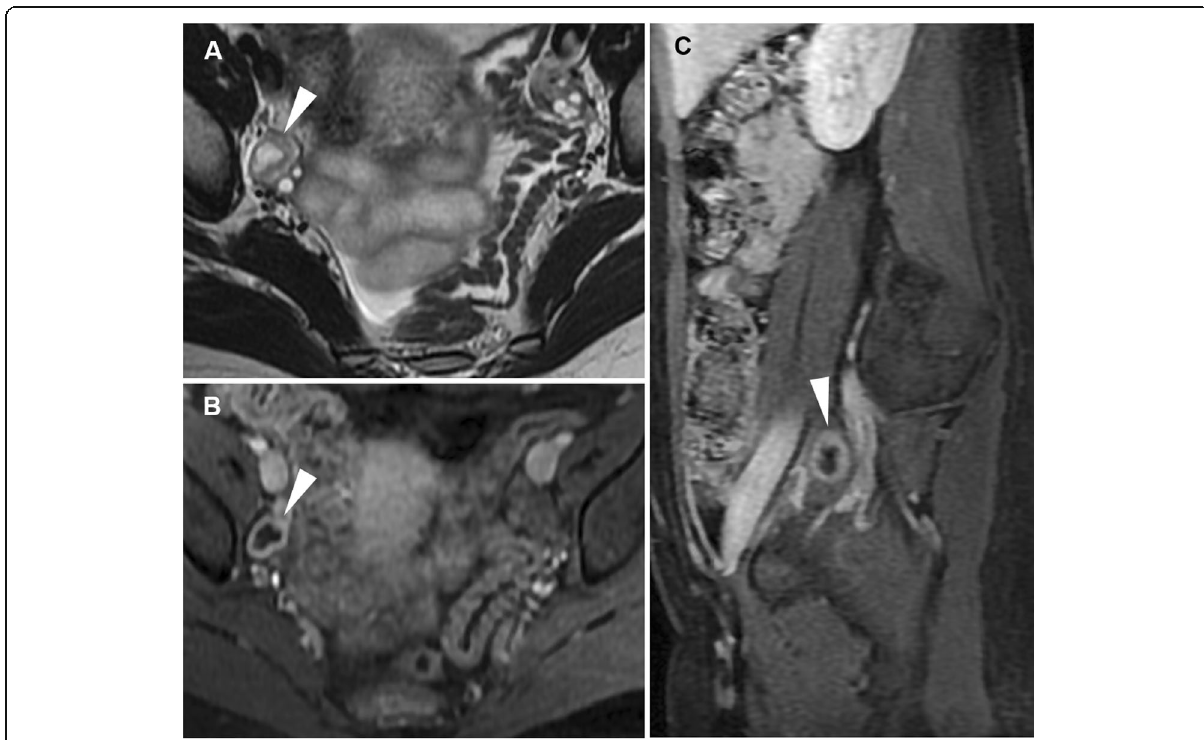
Fig. 2 Usual MRI appearance of an uncomplicated corpus luteum in a 26-year-old woman. Oblique-coronal T2-weighted ( a ), oblique-coronal ( b ) and sagittal ( c ) gadolinium-enhanced fat-suppressed T1-weighted images show a small-sized, unilocular fluid-containing structure in the right ovary (arrowheads), with typical homogenous T1-hypointense signal and T2-hyperintense signal, thickened walls with a crenulated enhancing rim